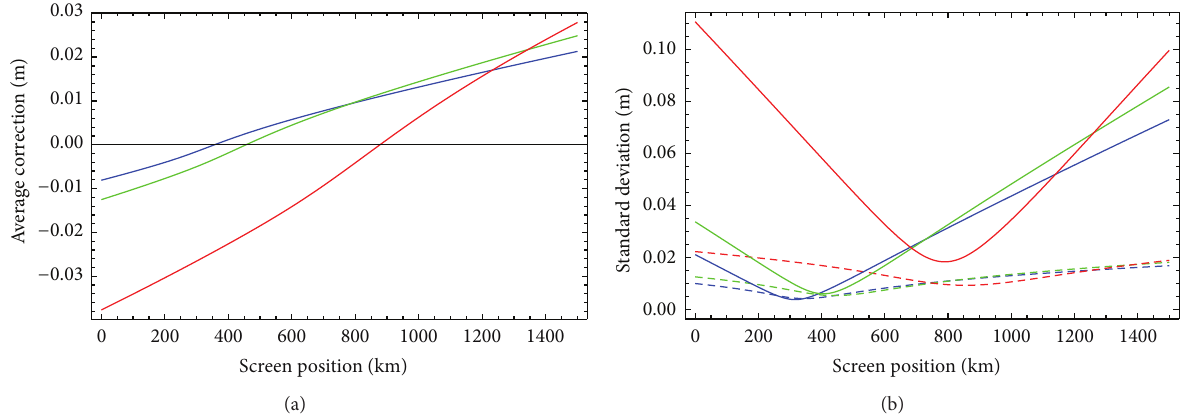
Figure 3: Virtual screen position dependencies of the average (a) and standard deviation (b) of corrections of first (dashed line) and third (solid line) orders for ionosphere-free combination (4) at the inner scale of 50 m and elevation angles of 90 ∘ (blue line), 50 ∘ (green line), and 20 ∘ (red line).